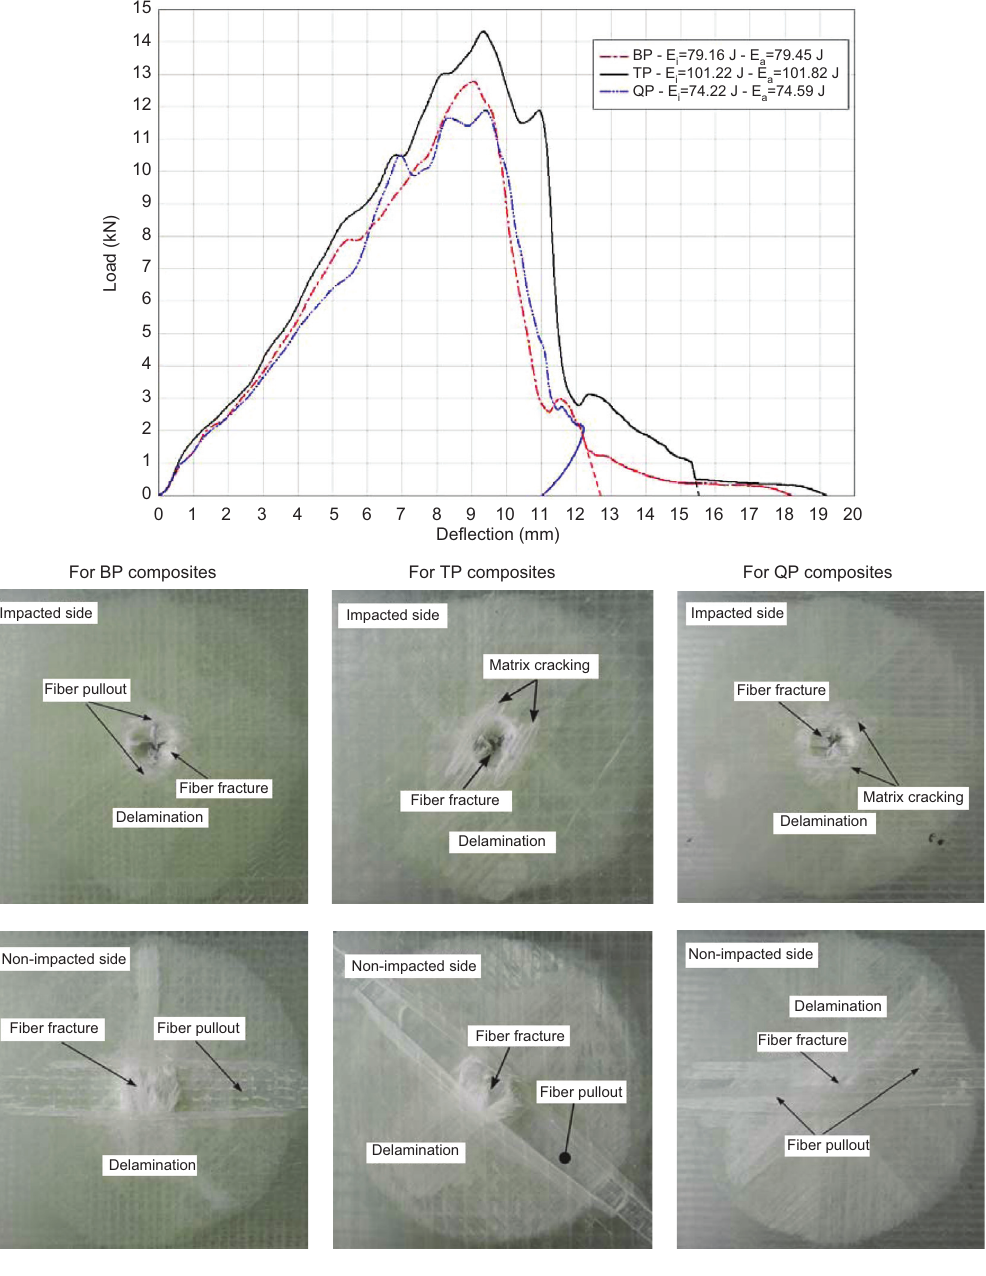
Figure 8 Typical load-deflection (F-d) curves of the BP, TP, and QP composites and images of damaged